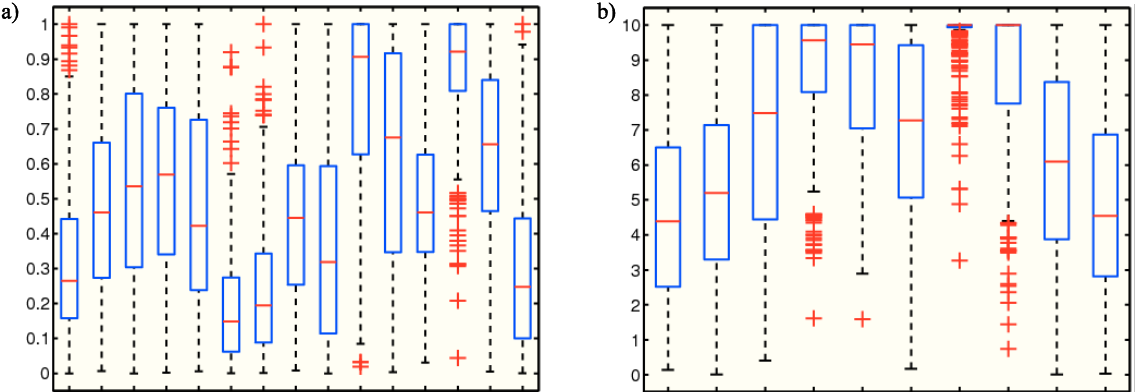
Figure 7: Distributions of selected fitted parameters. The boxes have lines at the lower quartile, median, and upper quartile values, and whiskers span 1.5 times the interquartile ranges. Outliers, indicated by red plus signs, are data with values beyond the ends of the